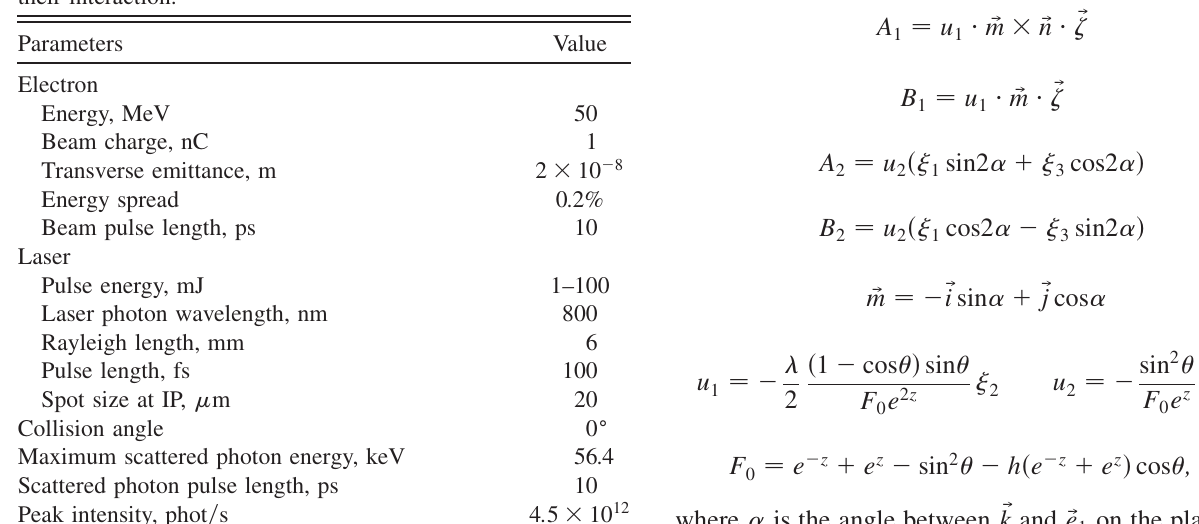
TABLE III. Parameters of the electron beam, laser pulse, and their